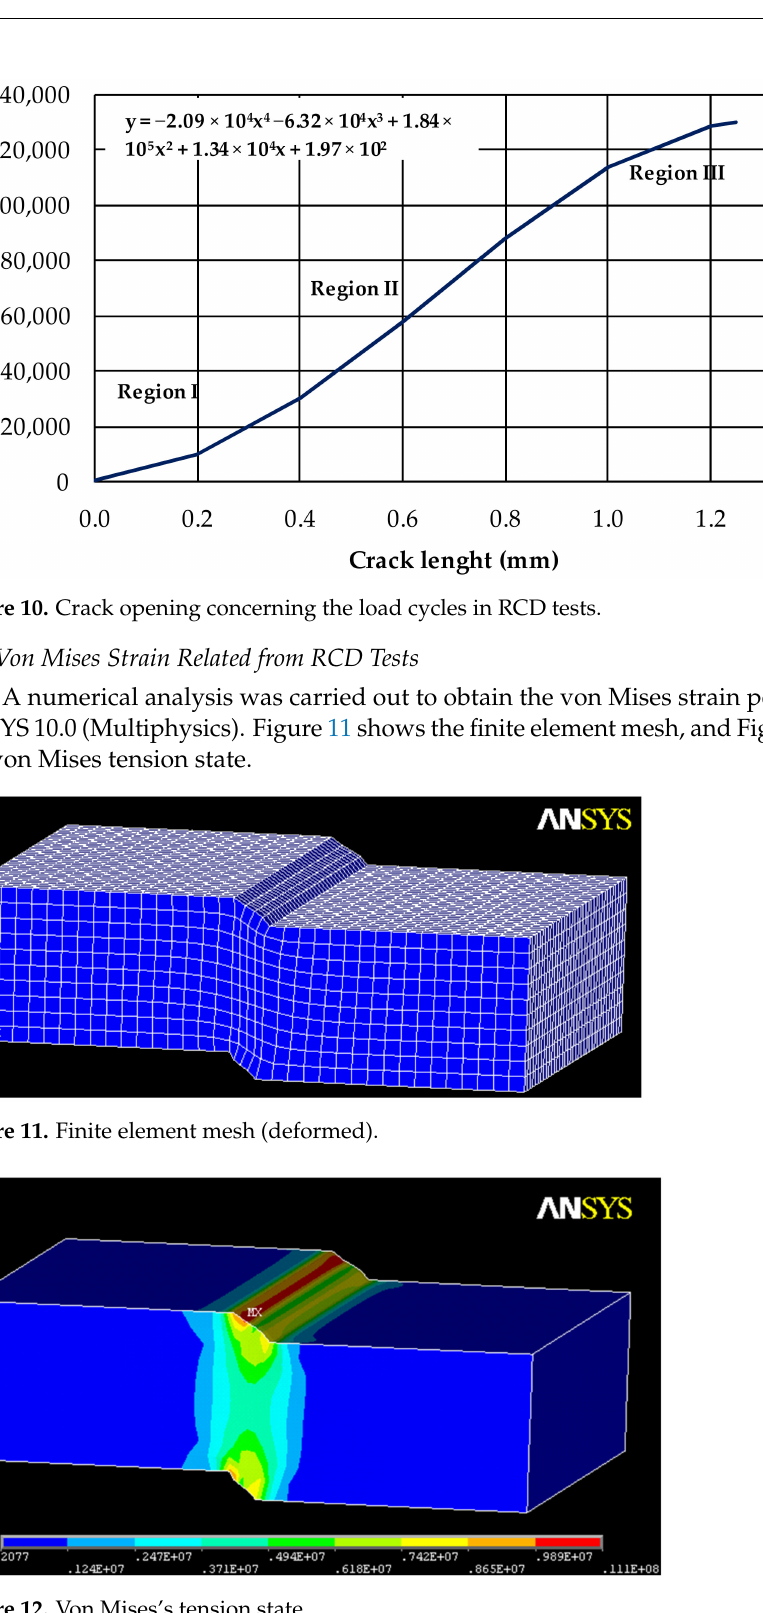
Figure 12. Von Mises’s tension